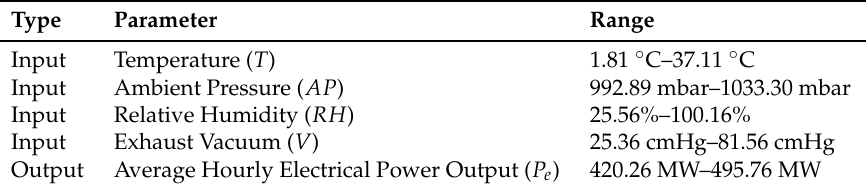
Table 2. Description of dataset parameters.